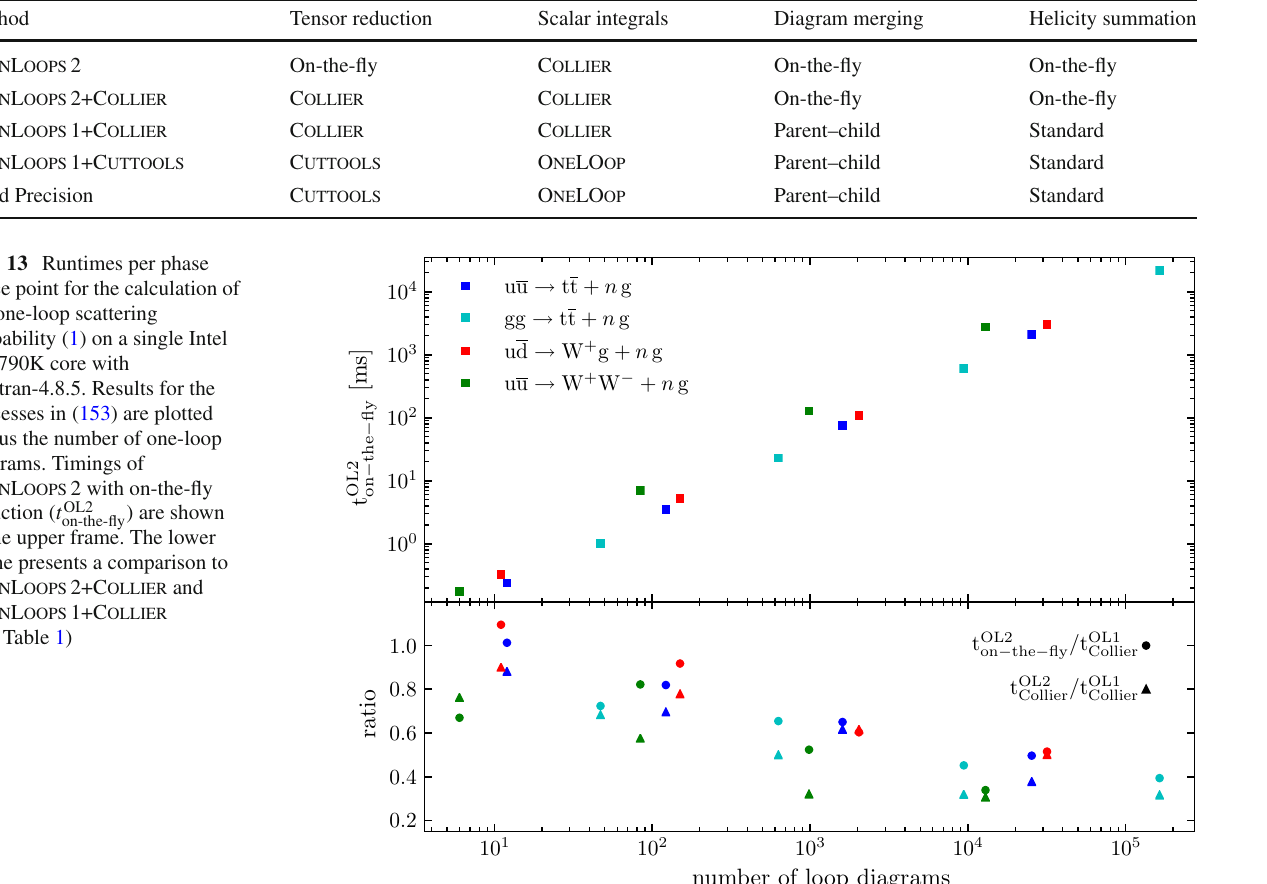
Table1 Listofthedifferentvariantsofthe OpenLoops programthatarecomparedinSects.6.2.1–6.2.2.Asthird-partytoolsweuse Collier1.2 [19], Cuttools1.9.5 [10] and OneLOop3.6.1 [65]